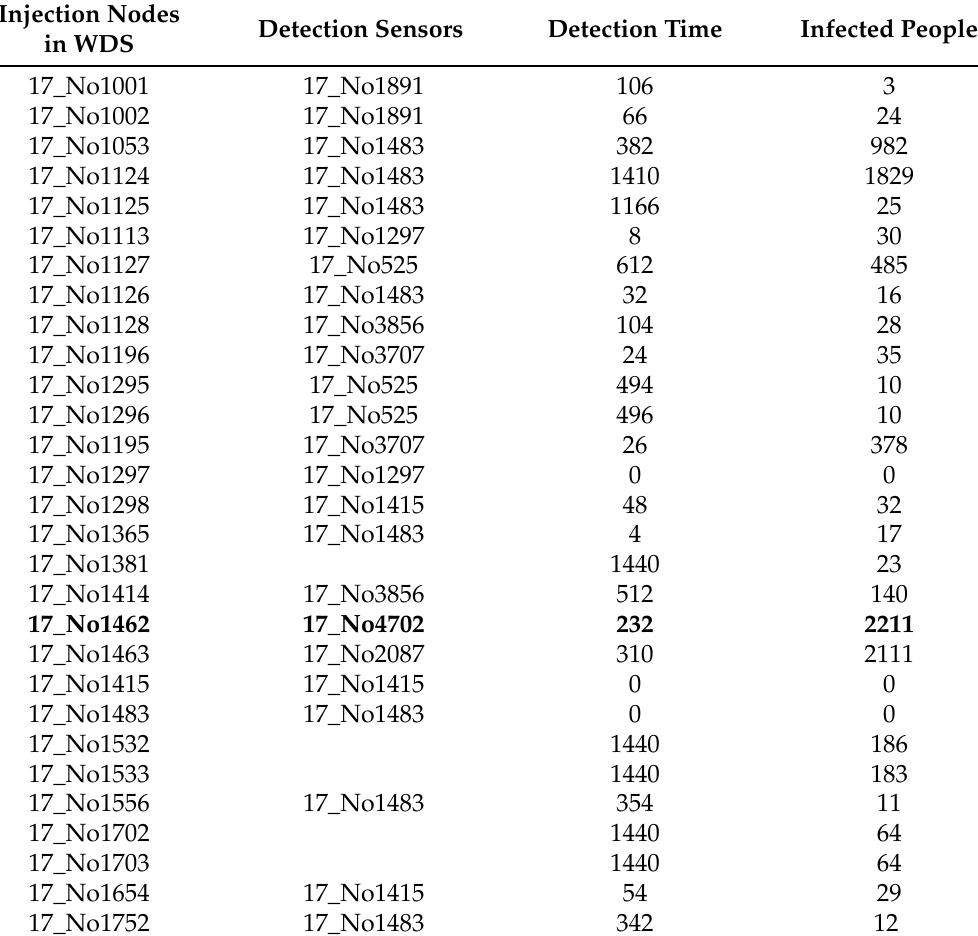
Table 4. Health impact with using 10 water quality sensors using